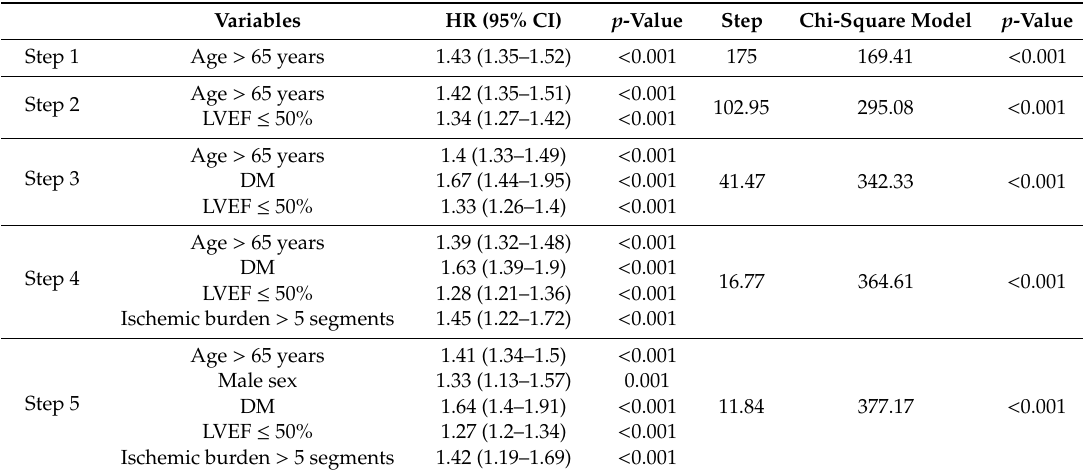
Abbreviations: stressCMR = Vasodilator stress cardiac magnetic resonance; DM = Diabetes mellitus; LVEF = Left ventricular ejection fraction; HR (95% CI) = Hazard ratio (95% confidence intervals).